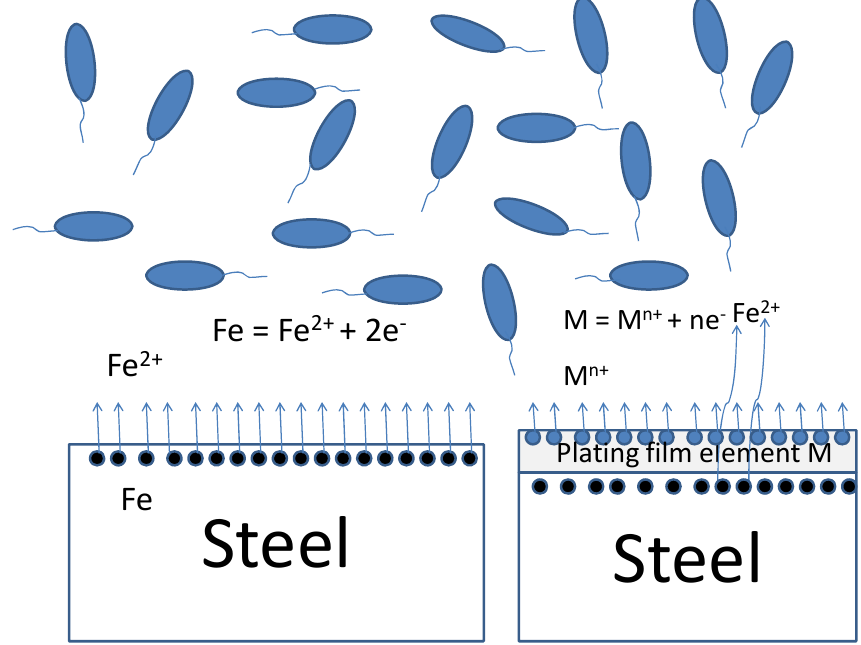
Figure 1. Schematic illustration of surface reactions at the interface between metals and